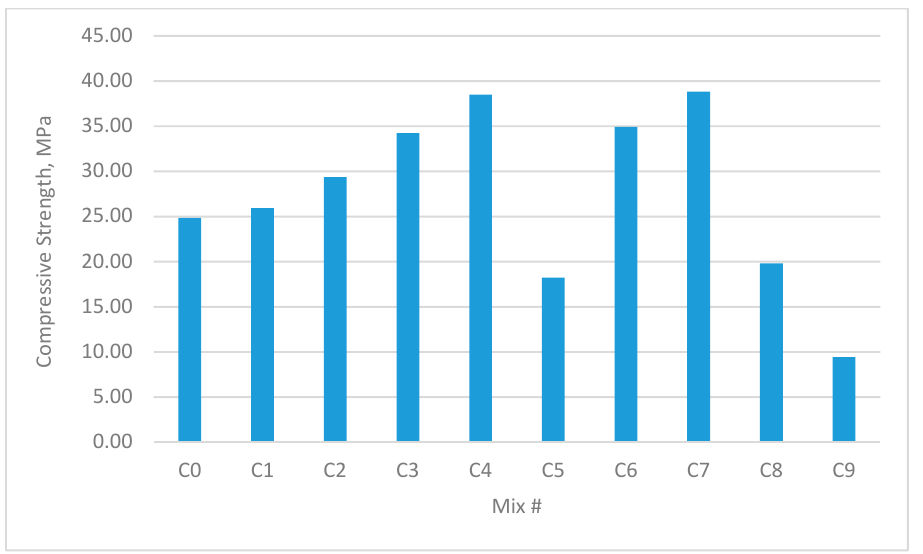
Figure 2. Compressive strengths of concrete cubes with W/B ratio 0.3.